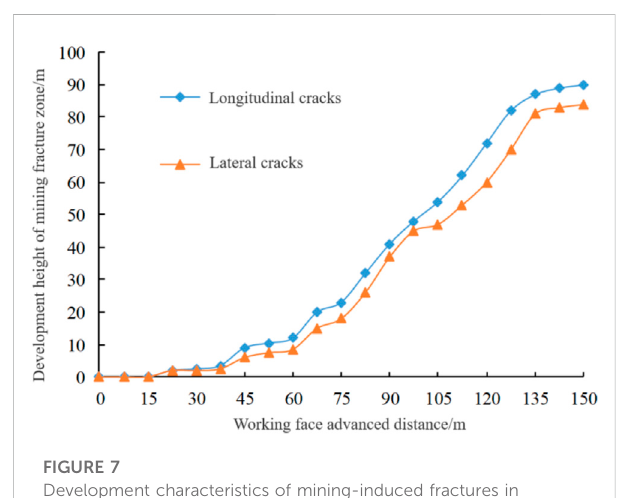
FIGURE 7 Development characteristics of mining-induced fractures in Baoshan coal